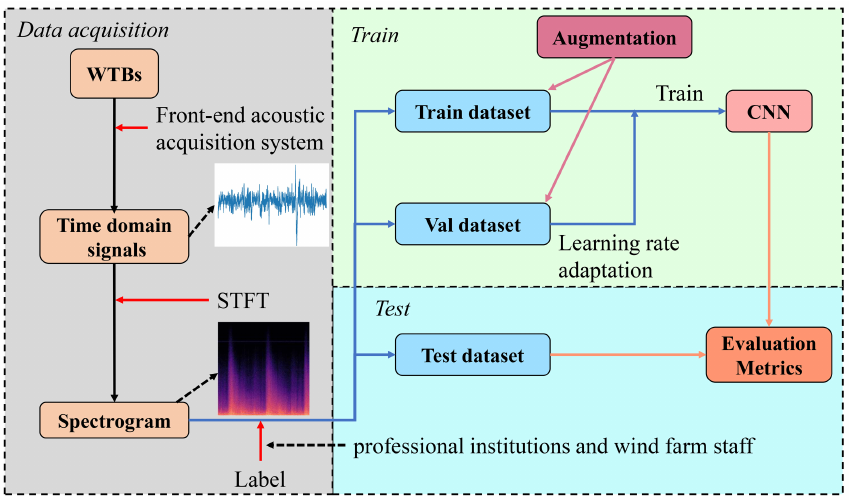
Figure 1. The framework of wind turbine blade defect detection based on